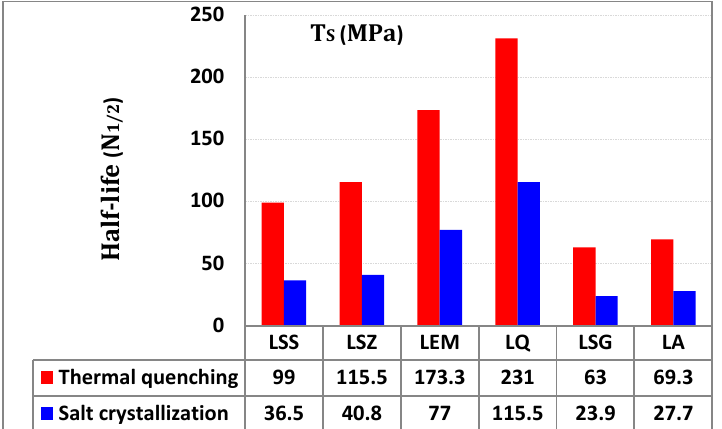
Figure 9. Half-life values of tensile strength of limestones under cyclic thermal and salt weathering.